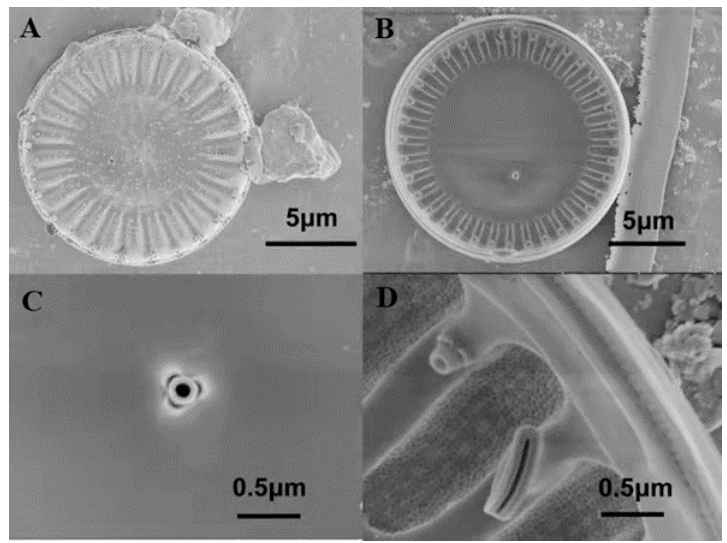
Figure 2. SEM micrographs of Cyclotella menegheniana MH2018001. ( A ) external view of C. menegheniana MH2018001; ( B ) internal view of C. menegheniana MH2018001; ( C ) showing the fultoportula; ( D ) showing the rimoportula positioned on a mantle costa).